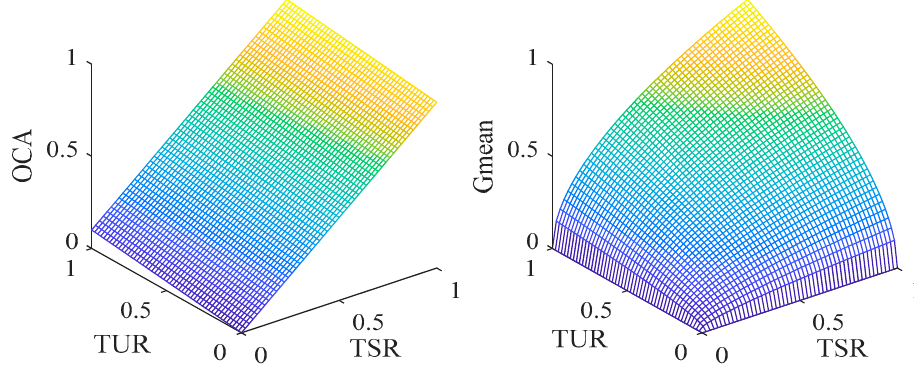
Figure 3. Comparison of overall classification accuracy (OCA) and geometric mean (Gmean).